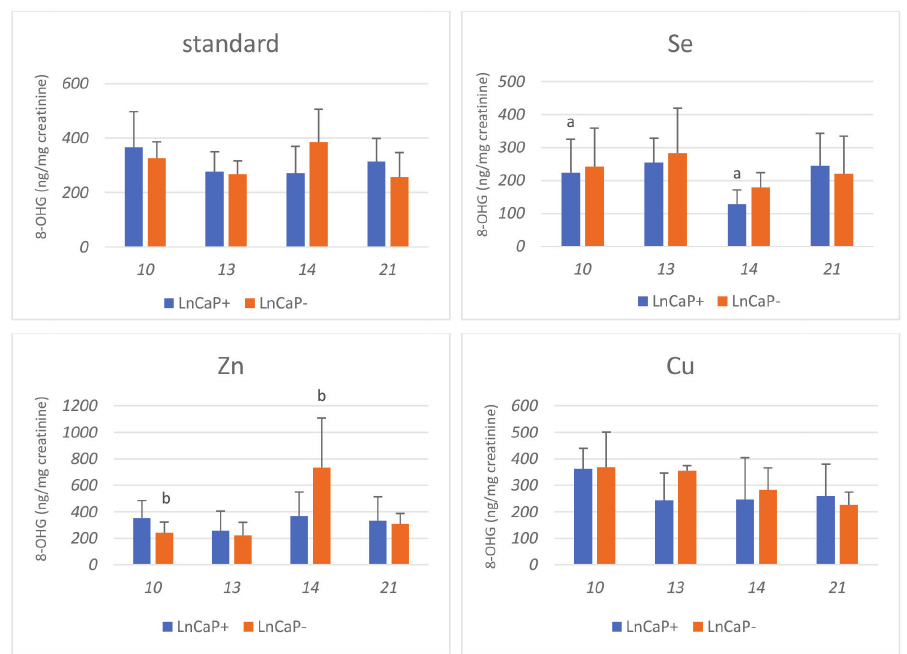
Figure 5: The effect of Se, Zn and Cu supplementation on the excretion of urinary 8-oxyguanine (ng/mg creatinine) (10-13-14-21 week) in rats treated and non-treated with prostate cancer cells. a – groups implanted cancer cells; group fed standard diet versus groups fed diet with addition of trace elements (p≤0.05). b – groups non-implanted cancer cells; group fed standard diet versus groups fed diet with addition of trace elements (p≤0.05). * - implanted versus non-implanted cancer cells